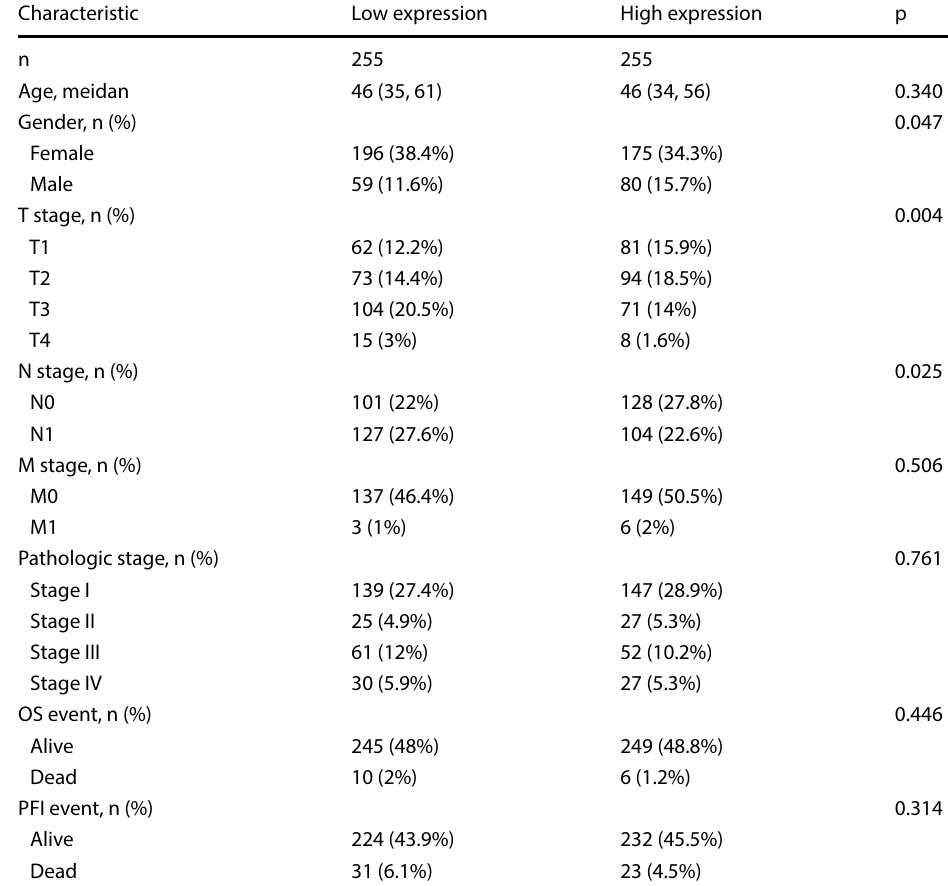
Table 1 The relationship between LINC01089 and the clinical